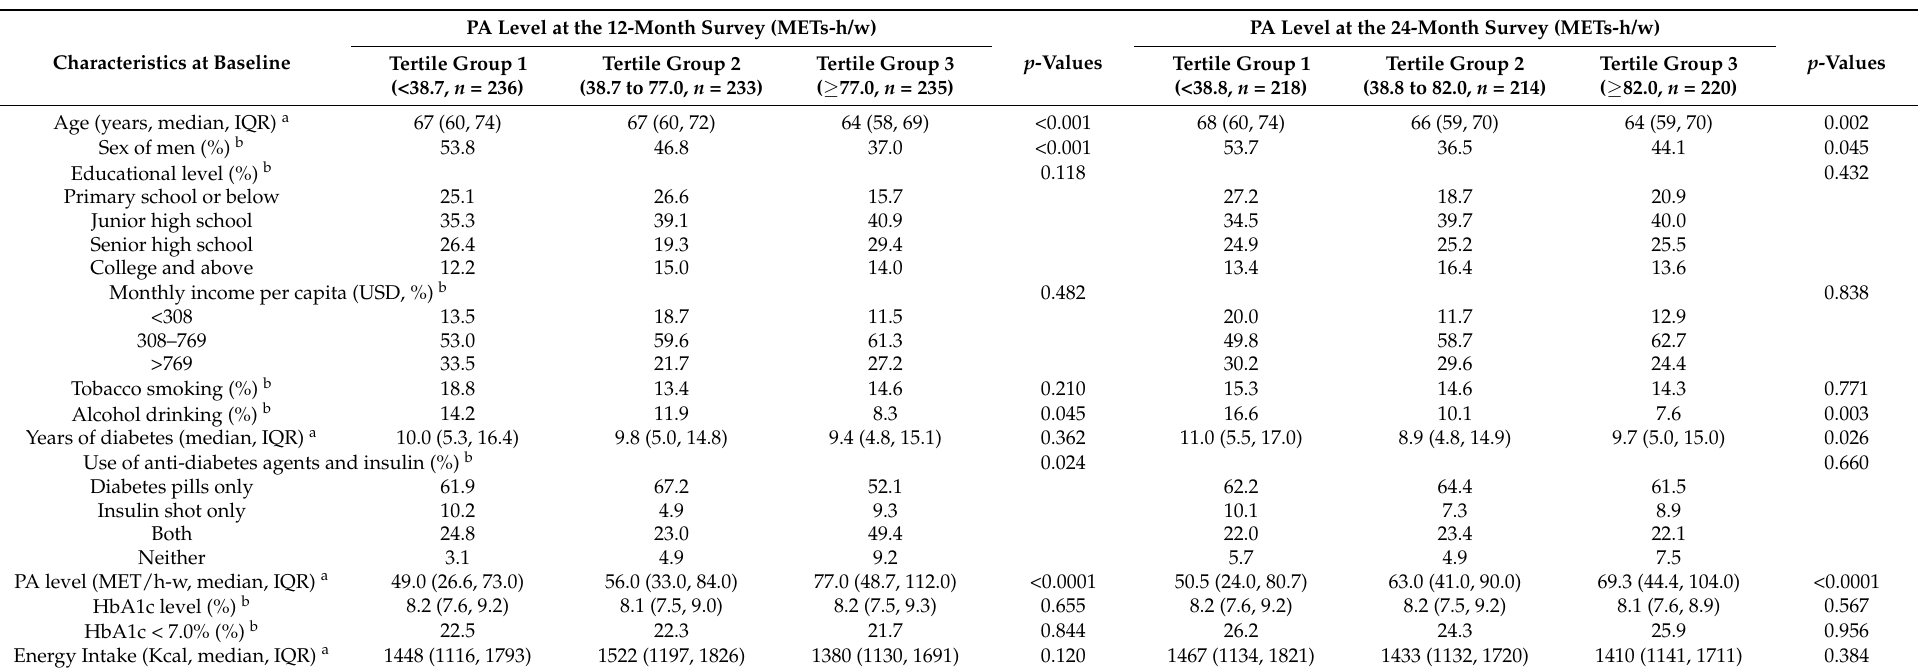
Table 3. Baseline characteristics of the study participants by tertile groups of PA at the follow-up